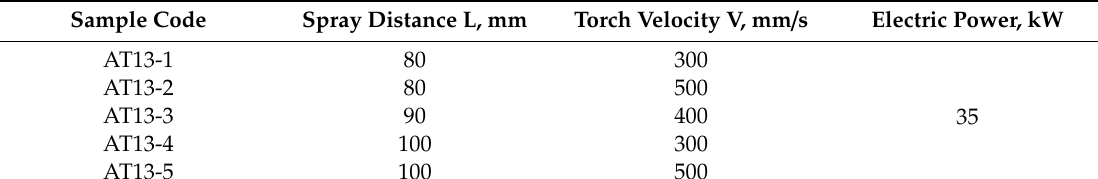
Table 1. The process parameters and sample labelling.